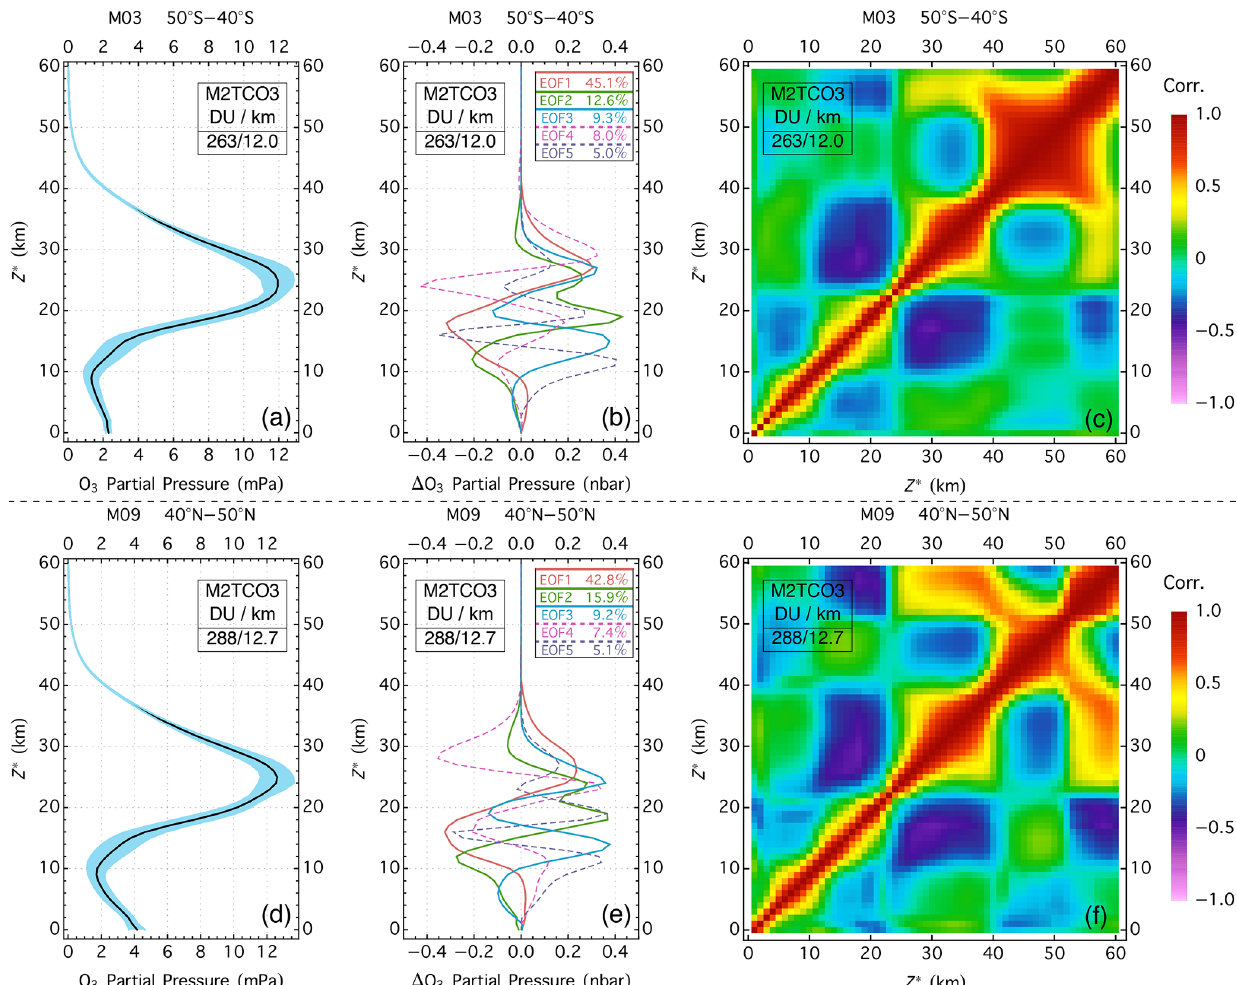
Figure 12. Examples of M2TCO3 climatological profiles for the southern midlatitude zone in March (a) and the northern midlatitude zone in September (b) , the associated correlation matrices (c, f) , and the corresponding modal O 3 profiles (b, e) . The blue shaded areas in panels (a) and (d) are within 1 standard deviation of the mean. The correlation matrices in (c) and (f) are standardized (i.e., diagonal element normalized to 1) covariance matrices. The five modal profiles in (b) and (e) are the first five ordered eigenvectors (also known as empirical orthogonal functions or EOFs) of the corresponding covariance matrices, with percentages of the profile variance explained by the EOFs displayed in the line legends. The text box in each panel displays the average tropopause altitude (in km) and the average total O 3 column (in DU) for the climatological